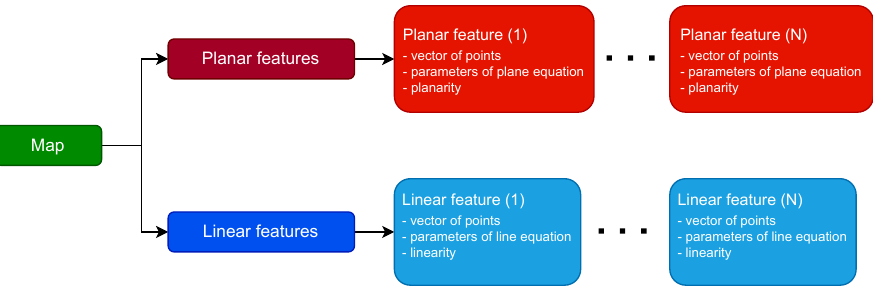
Figure 3. Structure of stored environment map consists of lines and planes forming high-level